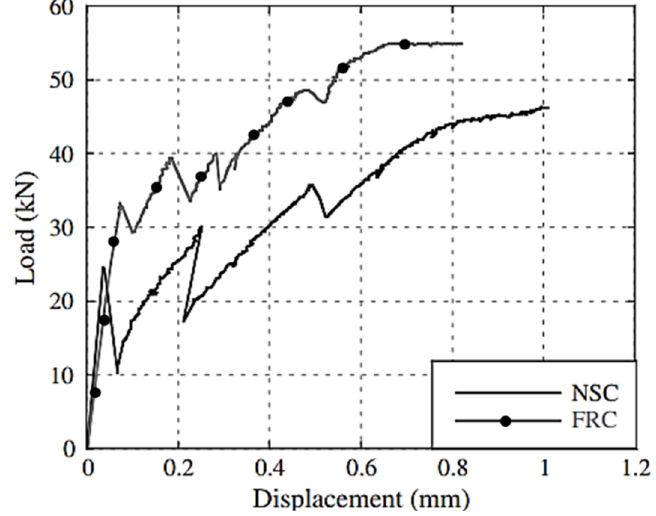
Figure 15. Load–displacement curves for tie-beams testing (Adapted with permission from reference [60]).